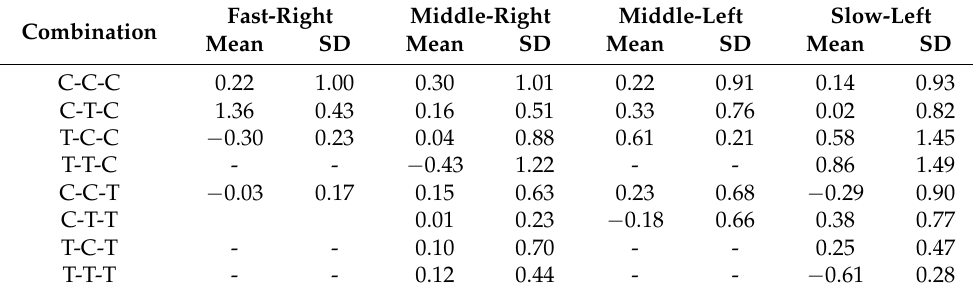
Table 7. The mean and standard deviation of T a difference between n4 and n6. Fast-Right Combination